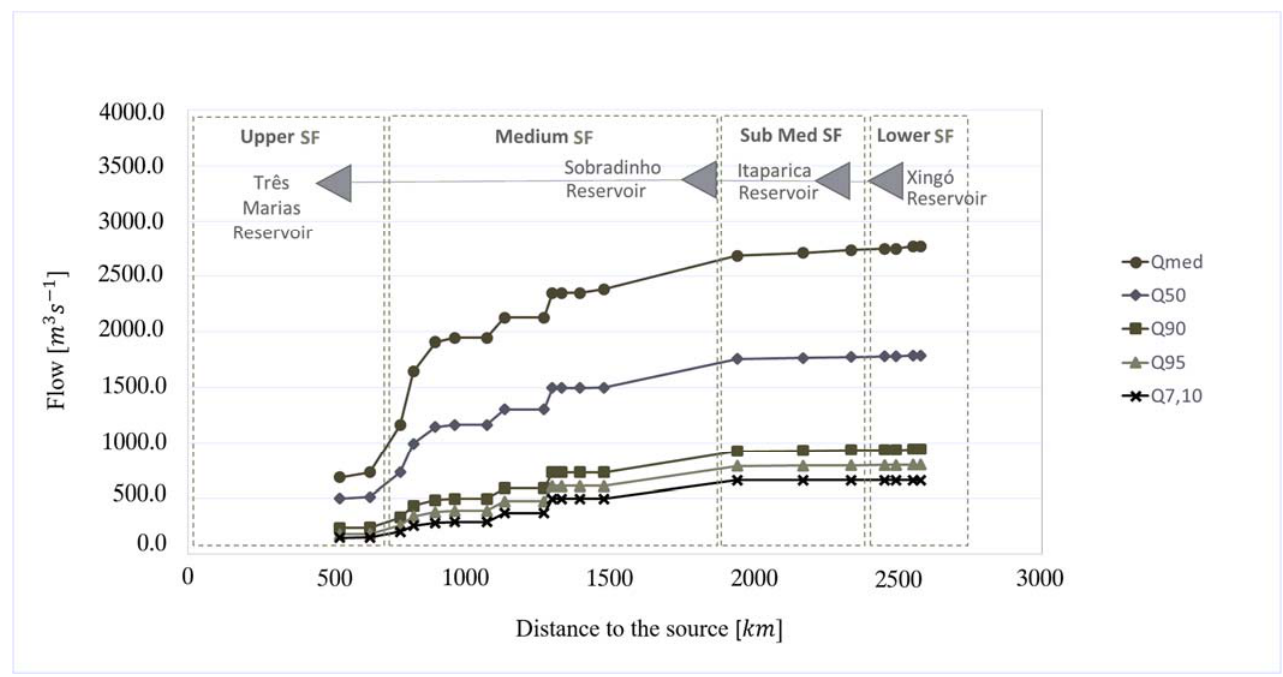
Figure 2. Average flows and permanent flows (1931–2013). Source: [45].